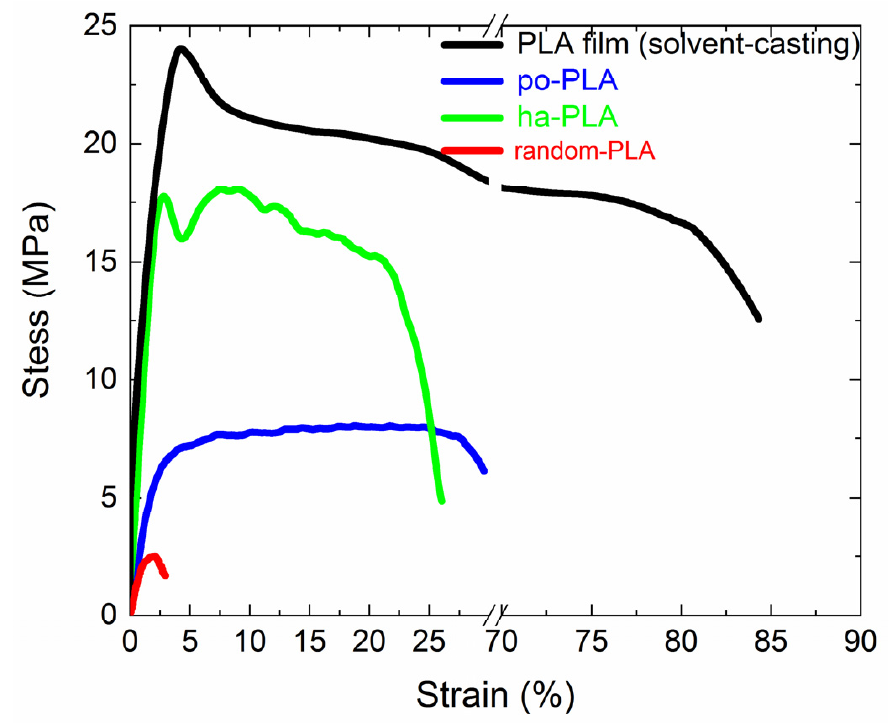
Figure 10. Stress-strain curves corresponding to PLA solvent-casted film (black line), partially oriented PLA electrospun fibers (blue line) and highly aligned PLA fibers (green line), and random- PLA fibers (red line). Table 5. Young’s modulus (E), tensile strength ( σ s ) and strain at break of PLA film, po-PLA and ha- PLA electrospun fibers.